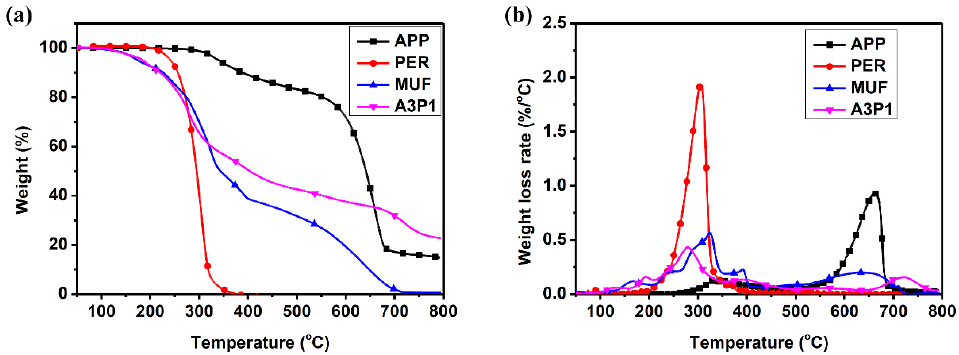
Figure 2. TGA ( a ) and DTG ( b ) curves of A3P1 and its